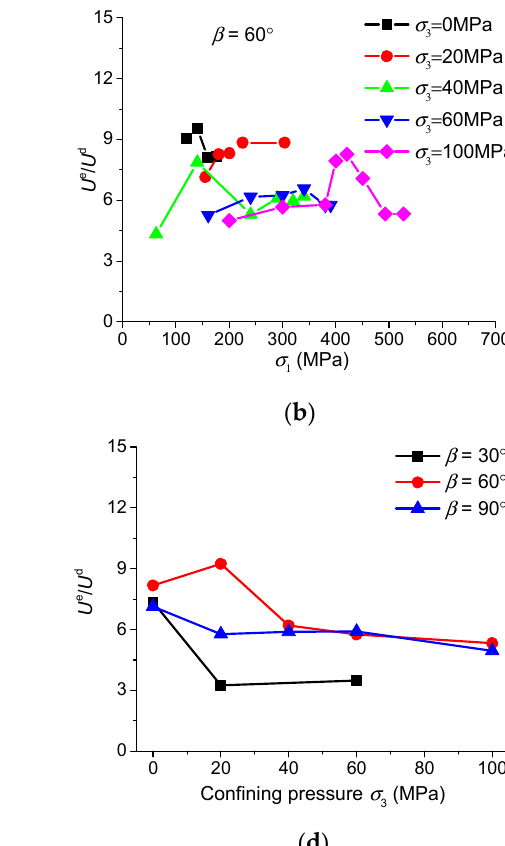
( c ) Figure 10. Dissipated strain energy with the increase of axial stress for the shale samples with different oriented weak planes under various confining pressures (( a ) σ 3 = 0 MPa, ( b ) σ 3 = 20 MPa, and ( c ) σ 3 = 60 MPa). The ratio of the releasable elastic strain energy U e to the dissipated strain energy U d has been defined as the burst proneness index, and the higher ratio of U e / U d indicates a higher probability of rock burst [42]. This ratio is also related to the brittleness index U e / U , and the higher ratio means that the rock material is more brittle [43]. Consequently, the ratio U e / U d is a very useful parameter to estimate the stability of wellbore or the brittleness of the shale reservoir. The ratios that were obtained from all conditions of the tests are plotted in Figure 11. Generally speaking, for most of the tests, the ratio increases at first with the increasing axial loading, then decreases when the peak strength is approaching. The ratio is lower at the beginning of loading as some energy is dissipated during the crack closure process. At the elastic and stable crack propagation processes, less dissipation of strain energy leads to the higher value of the ratio. When the peak strength is approaching, the ratio decreases again as more strain energy is dissipated with the unstable crack propagation and friction on the fracture surfaces. It is also observed that the change of this ratio is not very obvious for the tests under uniaxial compression, as the formation of extension fractures need lower strain energy than the coalescence of shear fractures under higher